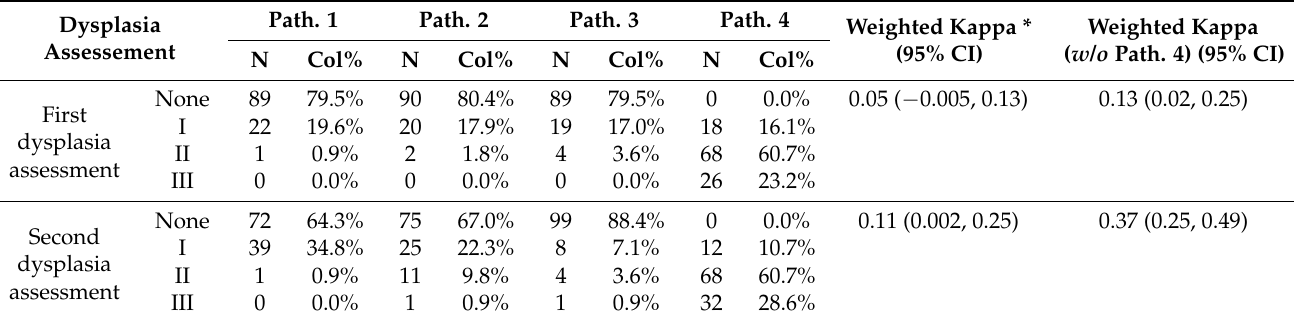
Table 2. Inter-rater reliability of the dysplasia